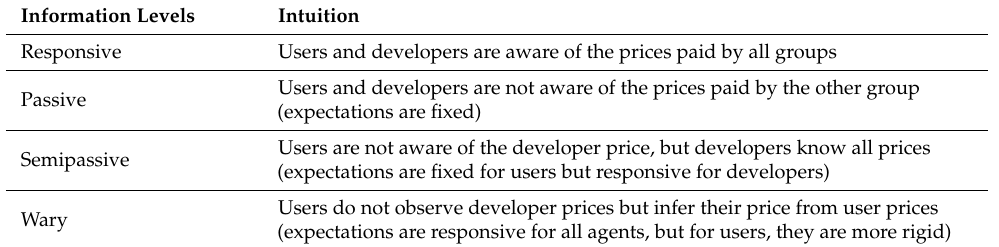
Table 1. Different types of information levels or ways to form expectations. Source: Own.